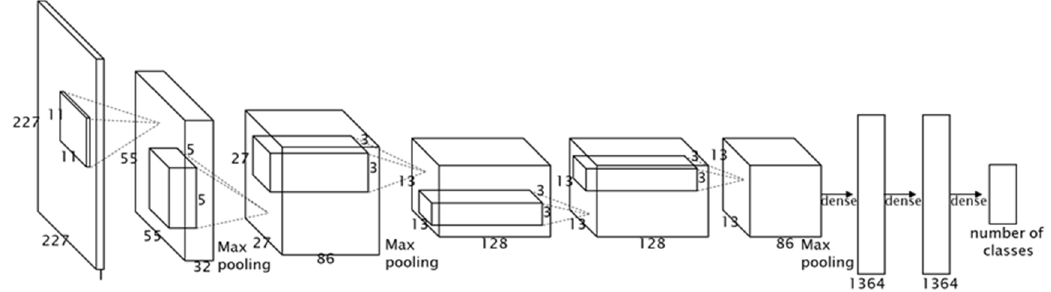
Figure 4. Deep learning model used for the classification of symbol images.